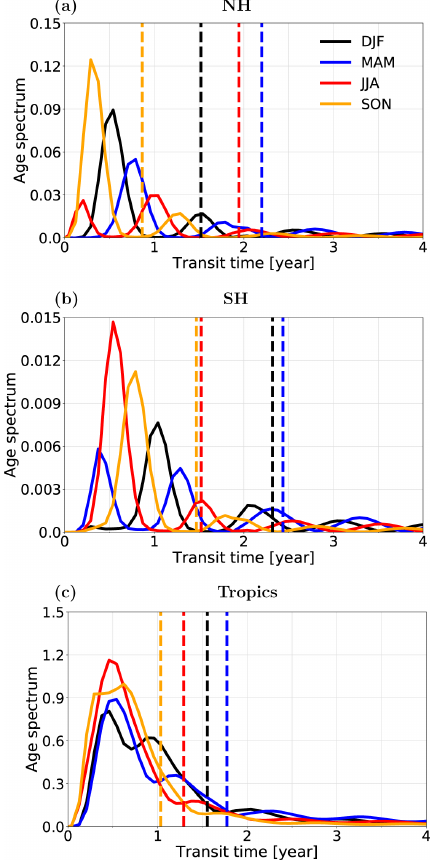
Figure 5. Partial age spectra of the air with the origin in NH extra- tropics (a) , SH extratropics (b) , and tropics (c) calculated at 360K along 60 ◦ N (destination region). Different colors represent differ- ent seasons. Vertical dashed lines indicate the mean AoA. Note different ranges of the y axis (tropics = 10 × NH; NH = 10 × SH), which quantify relative differences of the considered source